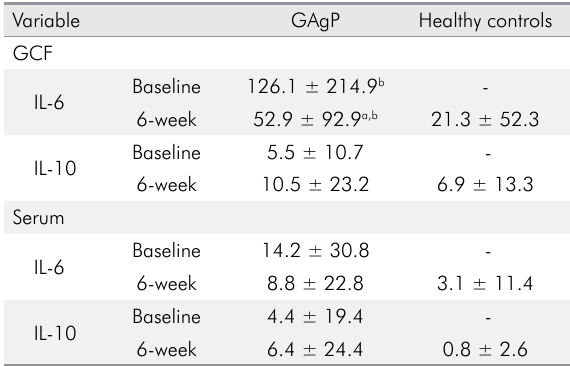
Table 4. Distribution of the IL-6 (-174) and IL-10 (-597) genotypes and allele frequencies for study groups. n(%).